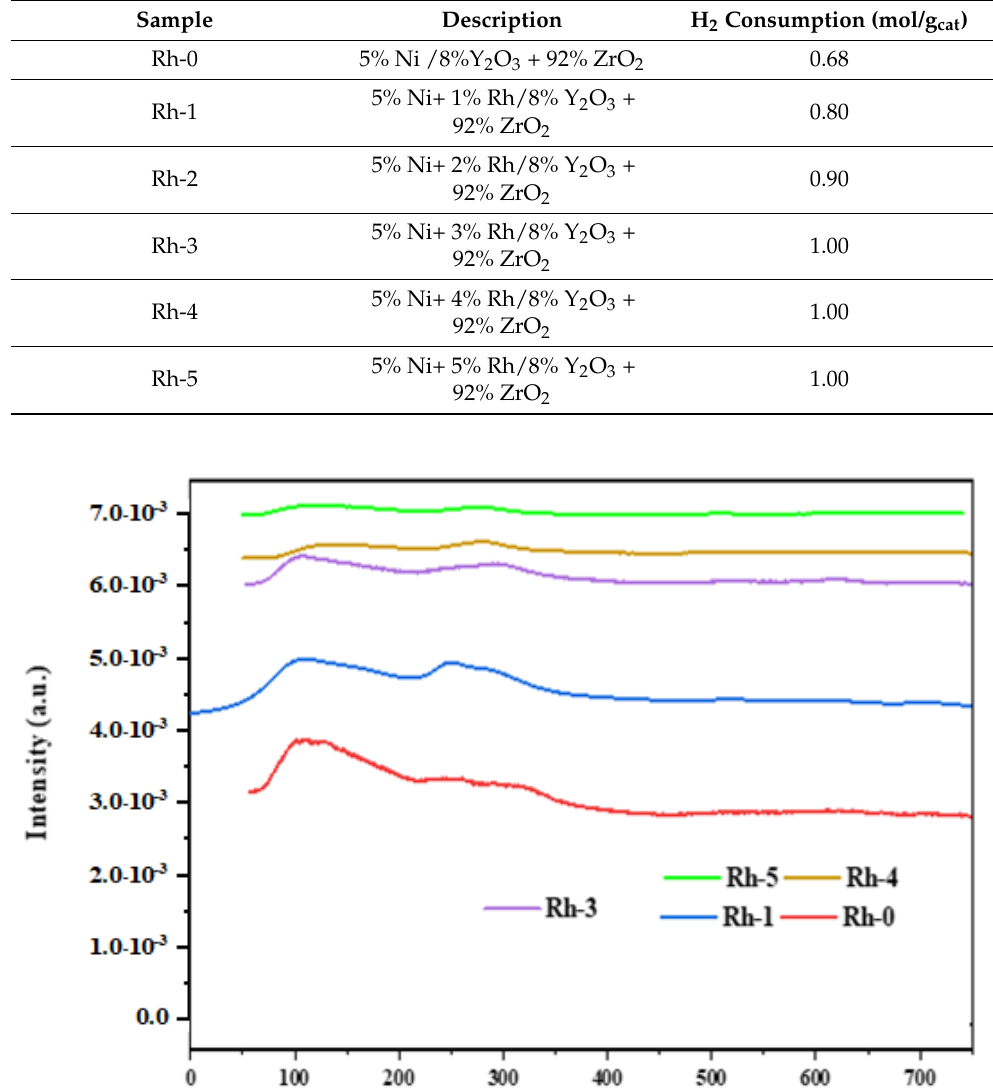
Table 2. H 2 consumption for promoted and unpromoted Rh 2 O 3 catalysts.